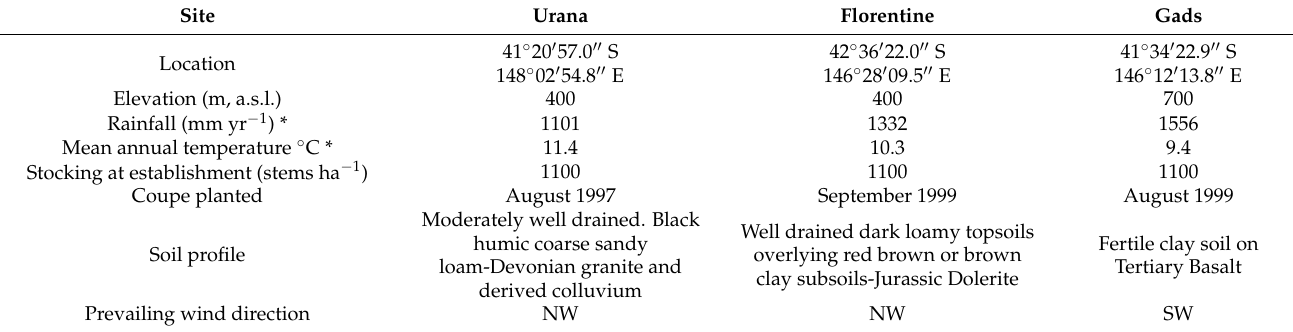
Table 1. Site description of three Eucalyptus nitens thinning trials in Tasmania,